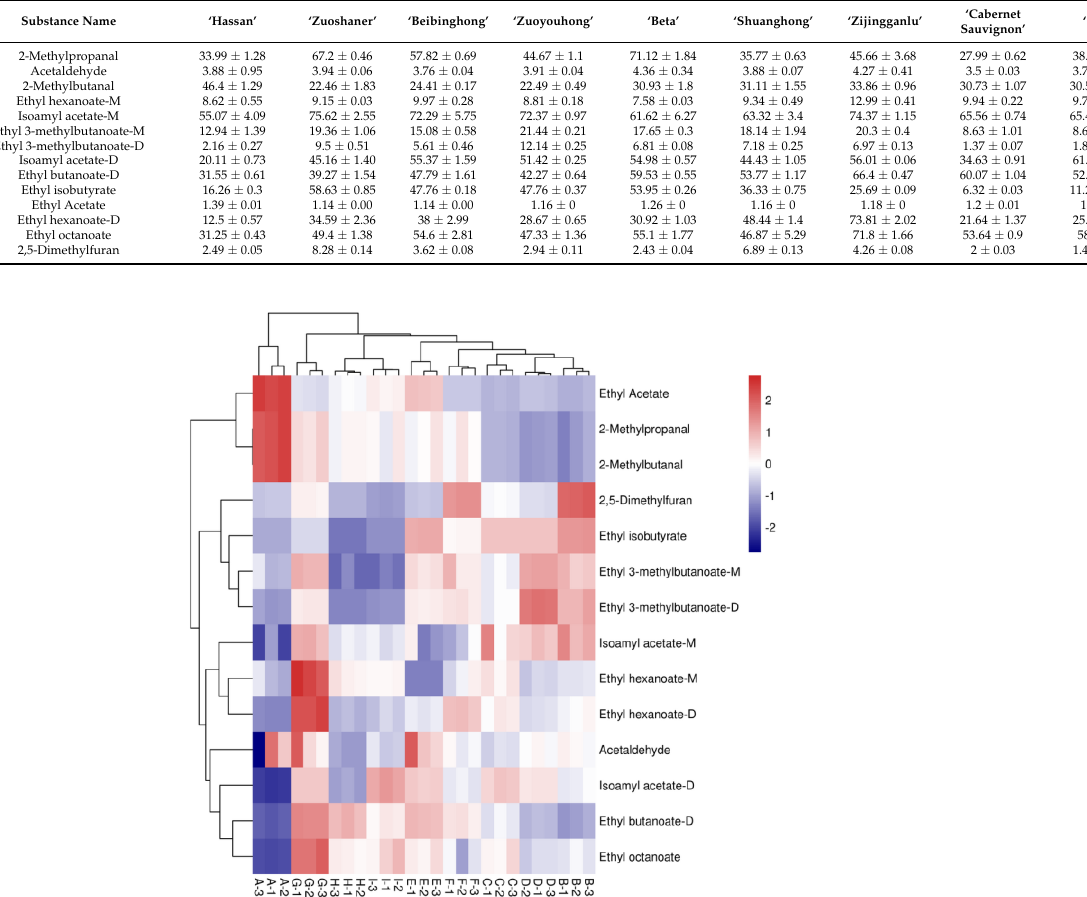
PC2. ‘Beta’ is located at the junction of quadrants two and three and is negative on PC2. ‘Hassan’ is in the third quadrant and is negative on PC1 and PC2. The ‘Cabernet Sauvignon’ and ‘Syrah’ samples were in quadrant four, with negative numbers on PC1 and positive numbers on PC2. This indicates that compounds with OAV values greater than one for volatile aromatic content vary considerably between wine samples of different varieties. Table 7. OAV Analysis of Main Aroma Compounds in Different Variety Wine Samples.